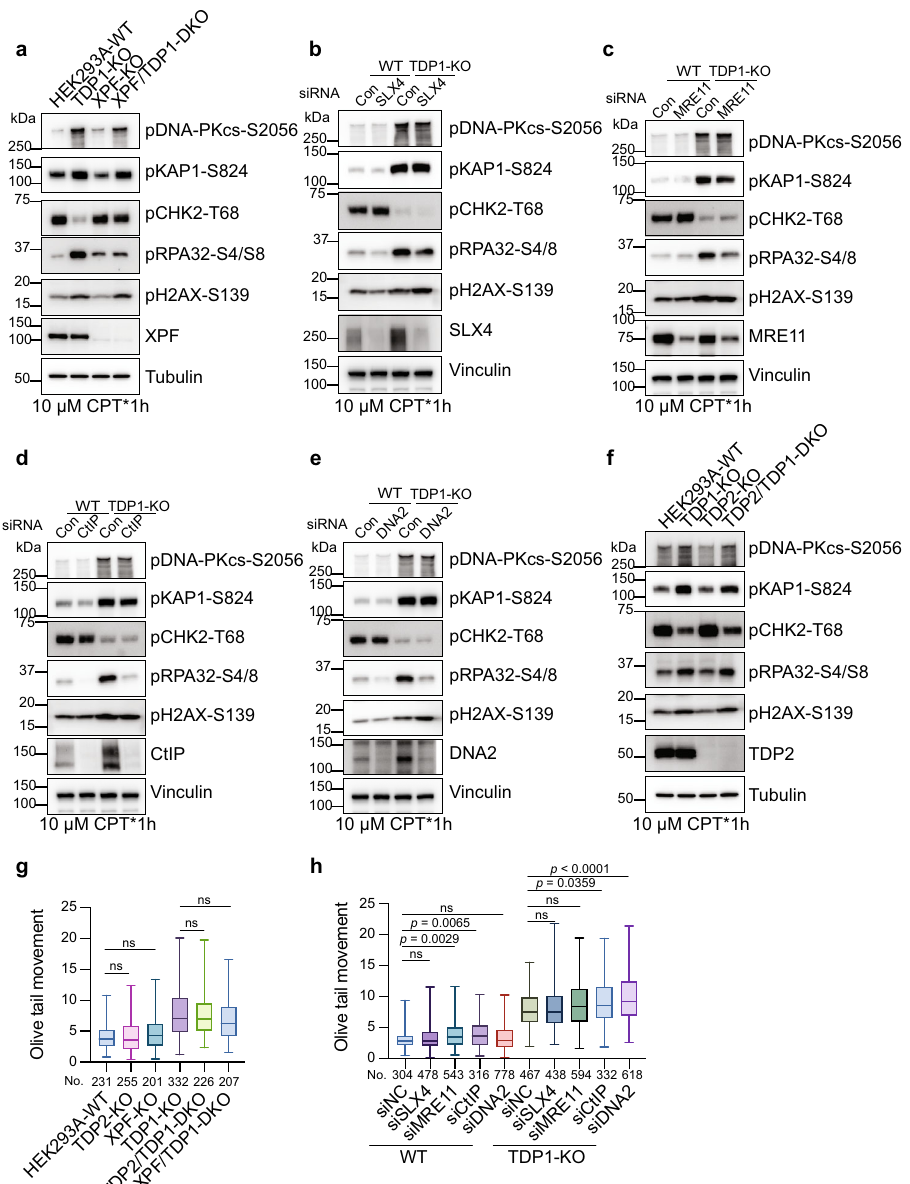
Fig. 6 Excision pathways that work in parallel with TDP1 in removing TOP1cc are not required for excess DSB generation with TDP1 loss. a HEK293A- WT, TDP1-KO, XPF-KO, and XPF/TDP1-DKO cells were treated with 10 µ M CPT for 1 h. Whole-cell extracts were prepared and subjected to Western blotting with the indicated antibodies. Experiments were repeated at least three times, and similar results were obtained. b – e Control siRNA or siRNA against SLX4 ( b ), MRE11 ( c ), CtIP ( d ), or DNA2 ( e ) were transfected into WT or TDP1-KO cells. 72 h after siRNA transfection, cells were treated with 10 µ M CPT for 1 h. Whole-cell extracts were prepared and subjected to Western blotting with the indicated antibodies. Experiments were repeated at least three times, and similar results were obtained. f HEK293A-WT, TDP1-KO, TDP2-KO, and TDP2/TDP1-DKO cells were treated with 10 µ M CPT for 1 h. Whole-cell extracts were prepared and subjected to Western blotting with the indicated antibodies. Experiments were repeated at least three times, and similar results were obtained. g A neutral comet assay was performed after treating the indicated cells with 1 µ M CPT for 1 h. Olive tail movement was measured by open comet software and plotted as a box plot. The center line indicates the median, the box bounds indicate the fi rst and third quartiles, and the whiskers indicate maximum and minimum. Numbers (No.) of cells examined were indicated. A one-way ANOVA Kruskal – Wallis test was used for statistical analysis. ns, not signi fi cant. h Control siRNA or siRNA against SLX4, MRE11, CtIP, or DNA2 were transfected into WT or TDP1-KO cells. 72 h after siRNA transfection, a neutral comet assay was performed after treating cells with 1 µ M CPT for 1 h. Olive tail movement was measured by open comet software and plotted as a box plot. The center line indicates the median, the box bounds indicate the fi rst and third quartiles, and the whiskers indicate the maximum and minimum. Numbers (No.) of cells examined were indicated. A one-way ANOVA Kruskal – Wallis test was used for statistical analysis. ns not signi fi